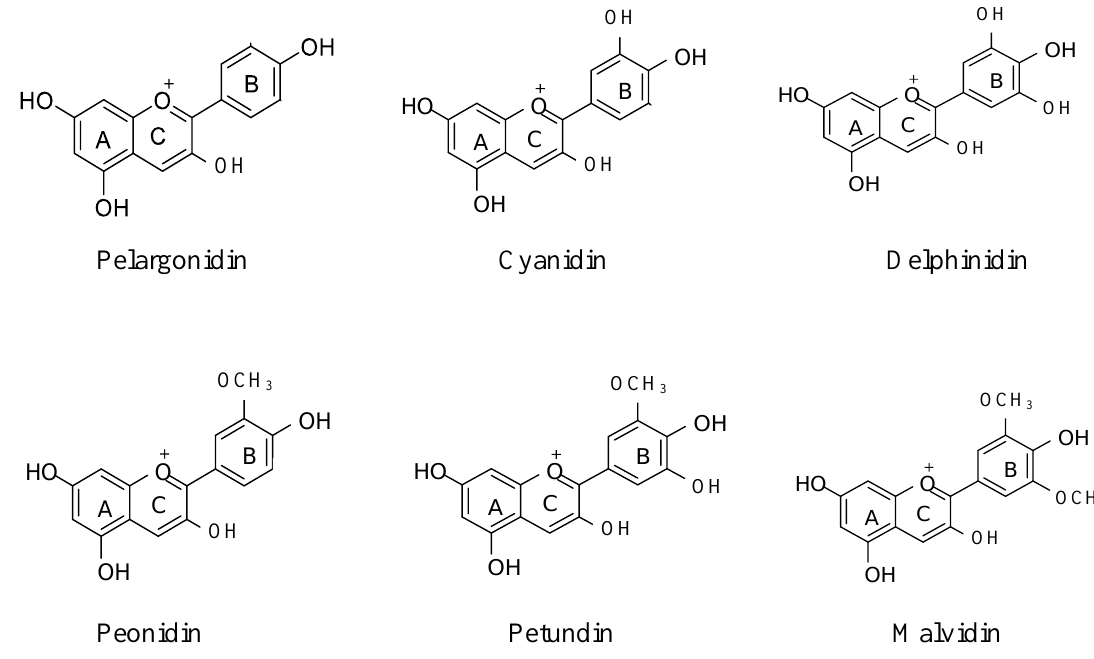
Figure 2. Structure of six anthocyanin monomers. Glucose (Glu), galactose (Gal), arabinose (Ara), rutinose (Rut), rhamnose (Rham), and xylose (Xyl) are the most common sugars that are bound to anthocyanins as mono-, di-, or trisaccharide forms [25]. However, the bioavailability of anthocyanins is relatively low, and the content of anthocyanins absorbed into the blood by the body only accounts for 1% of the total intake [26]. The low absorption and bioavailability of anthocyanins